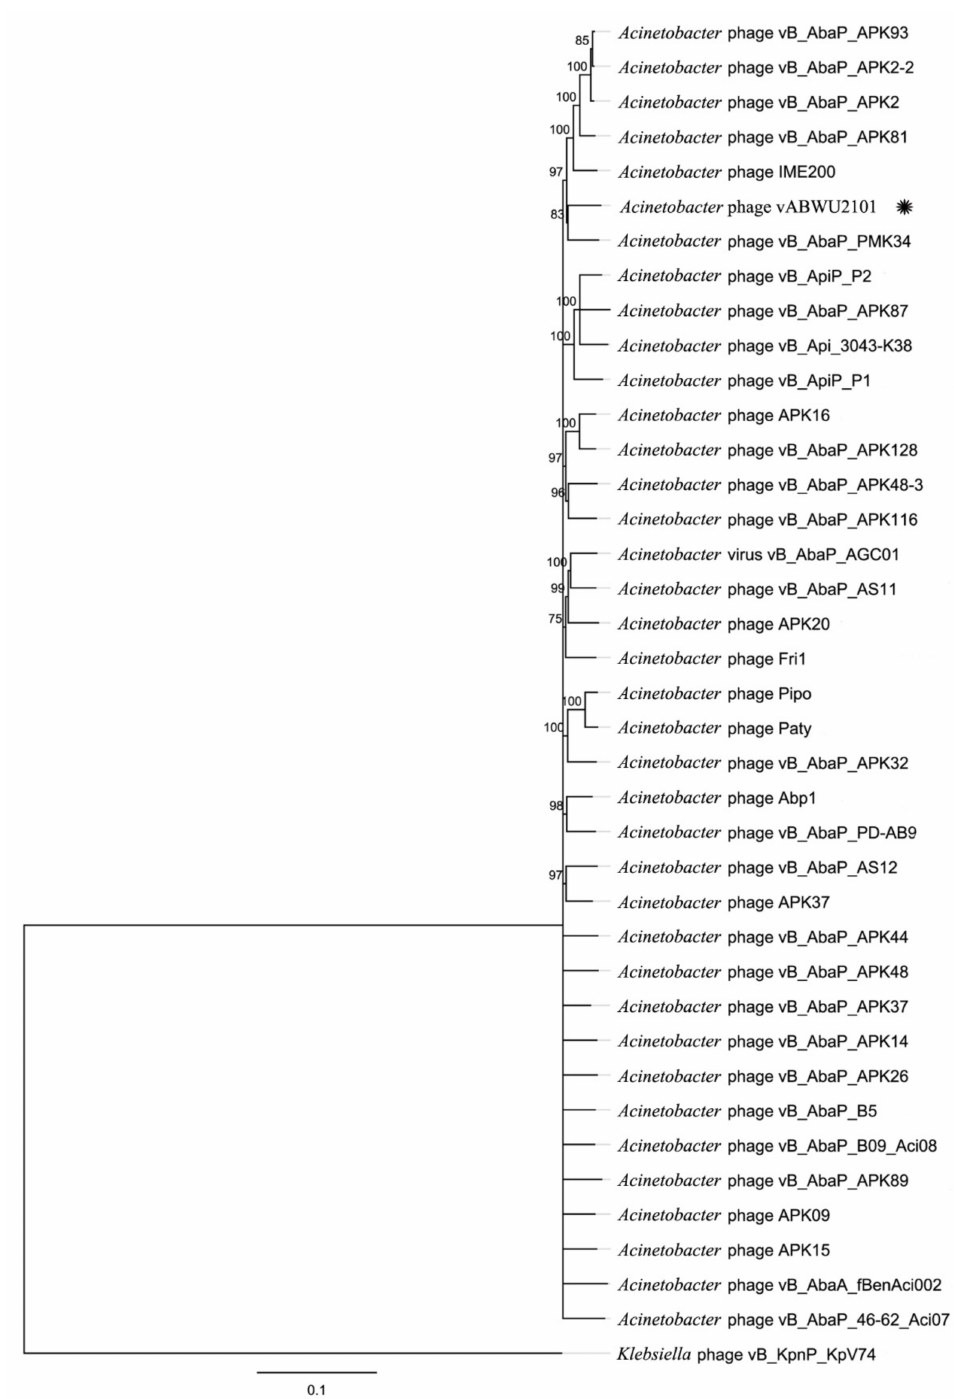
Figure 4. Phylogenetic tree analysis of phage vABWU2101 based on whole genome sequence comparisons of selected phages. The whole-genome phylogeny was constructed by the Geneious server using the neighbor-joining phylogenetic tree based on the JTT model with 500 bootstrap replications. Bootstrap percentages (>70) from the neighbor-joining method are represented at the nodes of the branches (above). The scale bar represents 10% nucleotide substitution percentage. Phage vABWU2101 is marked with an asterisk. Klebsiella phage vB_KpnP_KpV74 was used as an